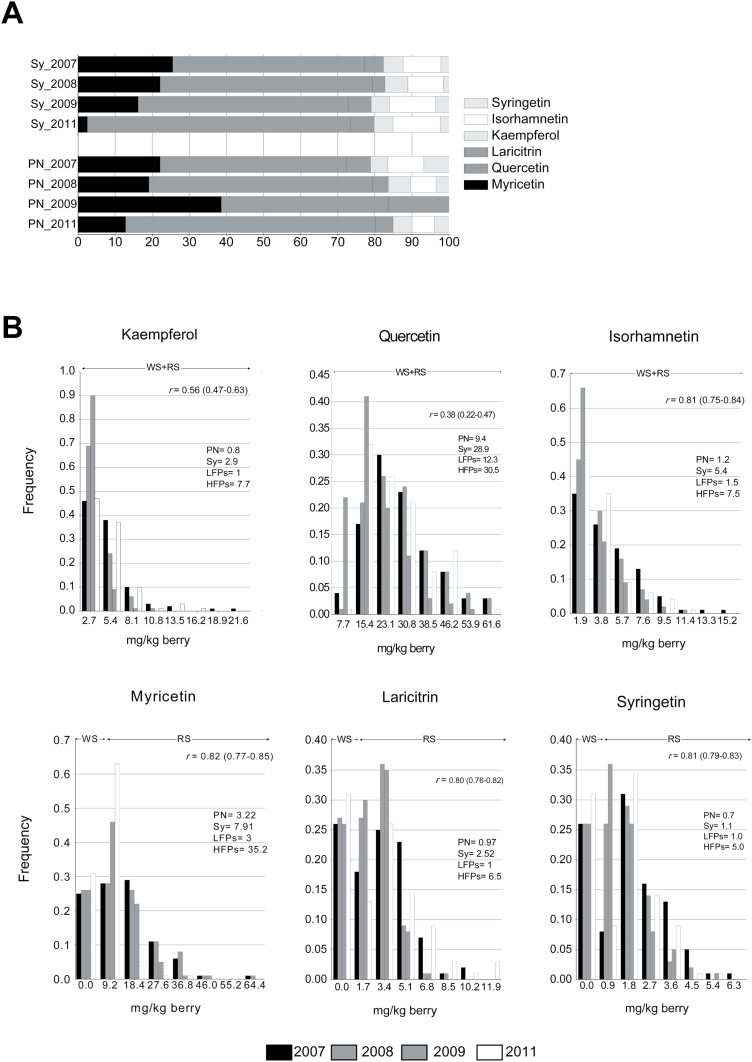
Variation of the flavonol content in the parental lines (A) and in the ‘Syrah’x‘Pinot Noir’ progeny (B) in berry skins at mature stage. (A) Profile of each flavonol in each year in the two parents of the cross. (B) Distribution of the progeny in classes at increasing content of each flavonol (mg kg–1 berry). In the right upper part of each plot, the Spearman rank-order correlation between years (r) (mean value and range of variation in parentheses) is shown for the whole progeny. Correlations are significant at the 0.01 level. For the two parents and for high- and low-flavonol producers, averaged values across years and across genotypes (in the second case) are reported. Abbreviations: Sy, Syrah; PN, Pinot Noir; LFPs, low-flavonol producers; HFPs, high-flavonol producers; WS, white-skinned individuals; RS, red-skinned individuals.